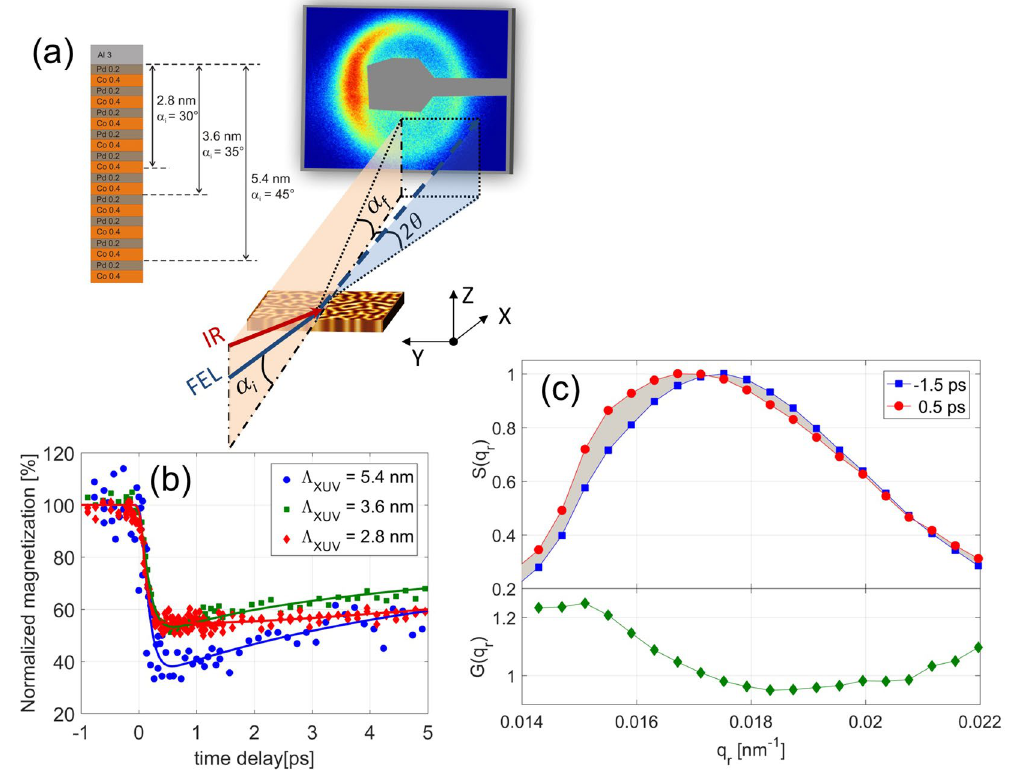
Figure 1. Experimental pump-probe setup in reflection geometry, demagnetization and structure factor. ( a ) XUV pulses incident at fixed angles α i probe the magnetic multilayer sample in penetration depths ranging from 2.8 to 5.4 nm. The IR pump pulse arrives with a small offset ( < 2°) w.r.t. the FEL beam on the sample. The CCD measures the resonant magnetic scattering signal where the intense specularly reflected beam is blocked by the beamstop and the IR radiation is absorbed by an IR filter (not shown) in front of the CCD. α f and 2 θ are the out-of-plane and in-plane scattering angles, respectively. ( b ) The time evolution of the normalized magnetization (measured as the area under the scattering peak). The lines are fits to the data points following Ref. 7 . ( c ) Upper panel: The scattering structure factor S q ( ) (normalized to its maximum) for an unpumped r = 3.6 nm. The lower panel shows the (blue, τ = − 1.5 ps) and for a pumped film (red, τ = 0.5 ps) at Λ XUV corresponding distortion